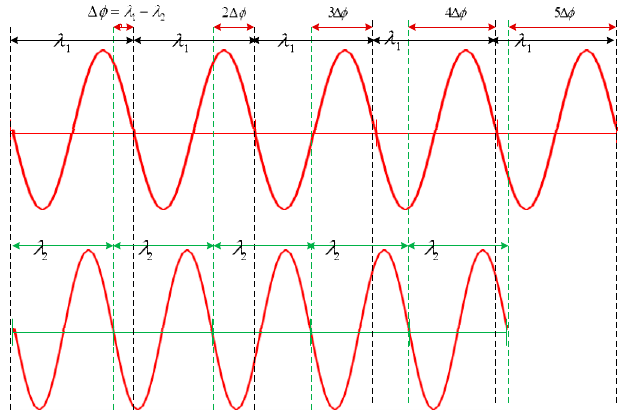
Figure 1. dual-frequency ranging principle.